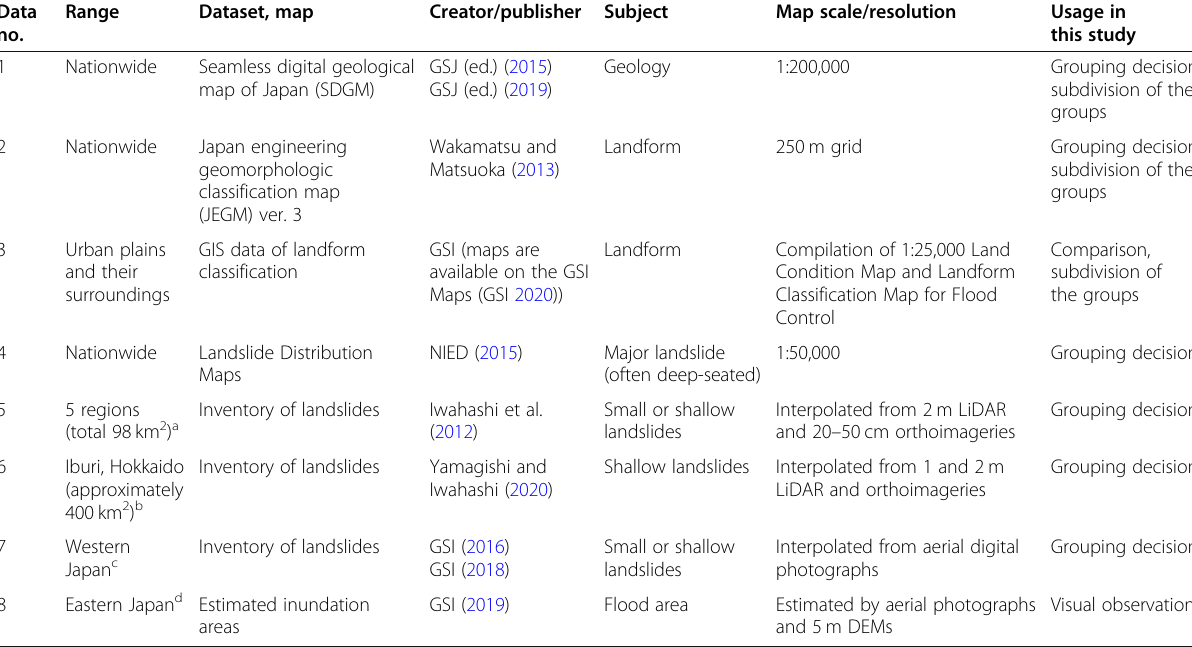
Table 2 Thematic map data used for comparison with the terrain classification of the current study Data